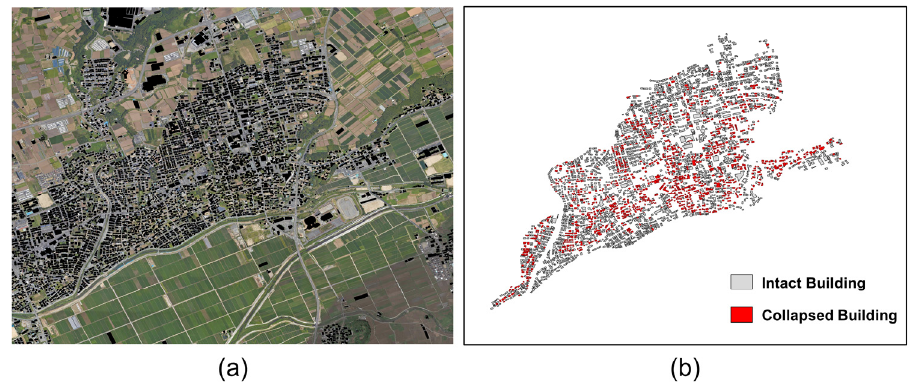
Figure 2. ( a ) OSM Building footprints in Mashiki town study area marked on Google Earth image. ( b ) Manually extracted building damage map for Mashiki town study area. The intact and collapsed buildings are displayed in gray and red color, respectively.